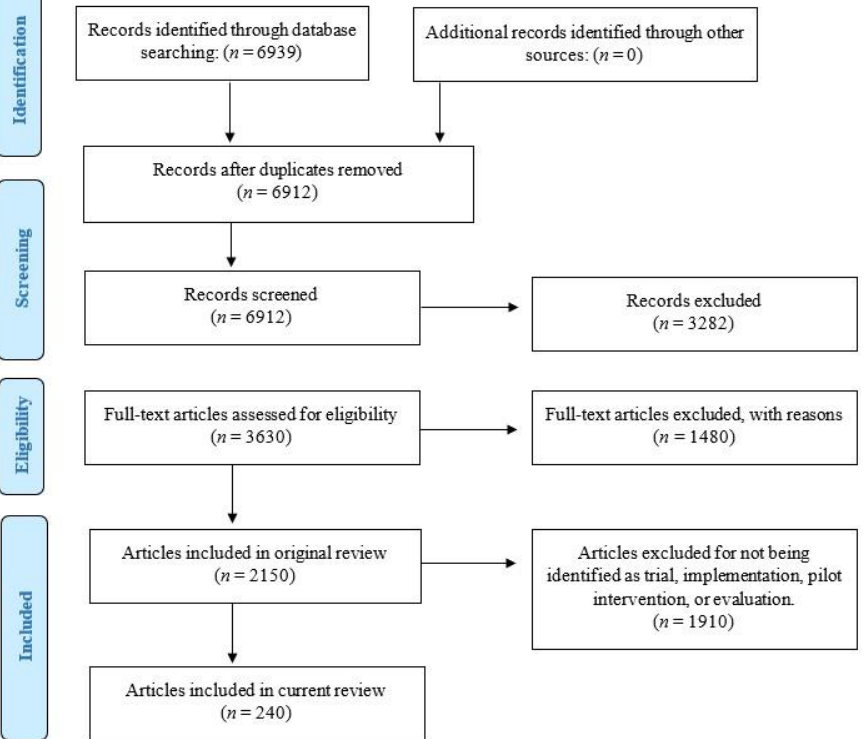
Figure 1. Preferred Reporting Items for Systematic Reviews and Meta-Analysis four-phase flow di-